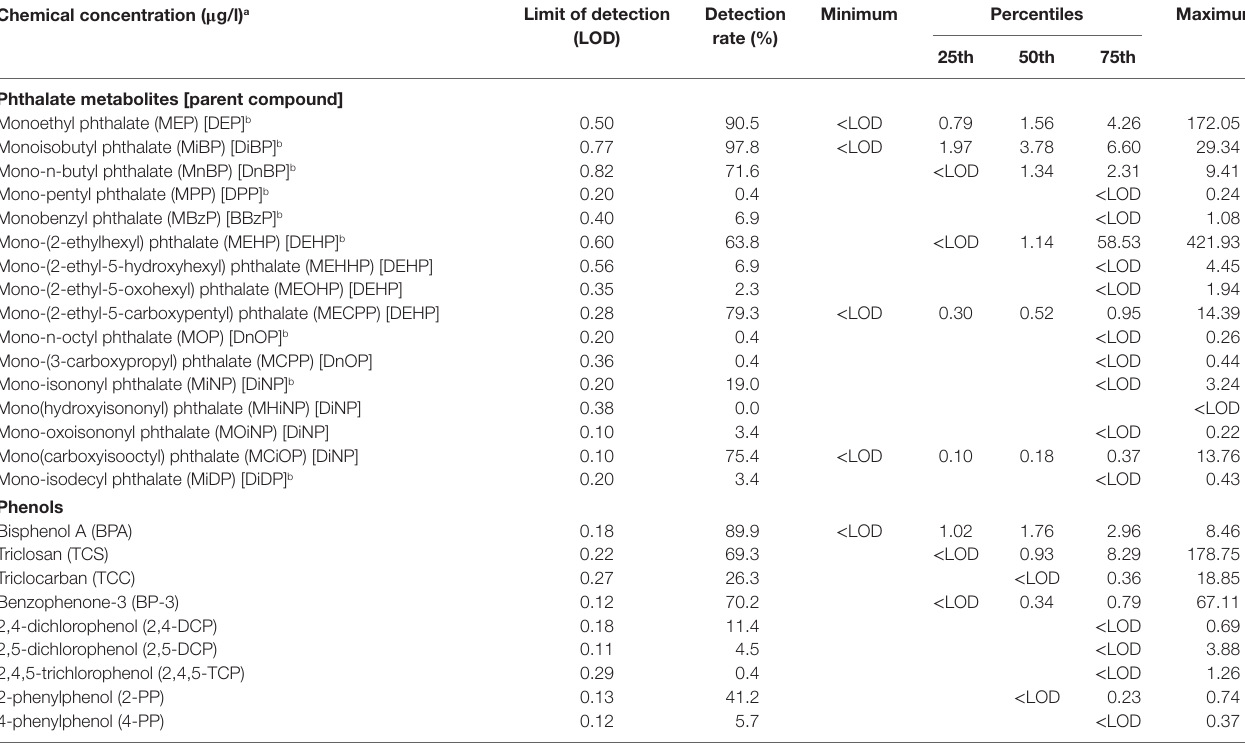
Table 1 | Medians, quartiles, and ranges of serum concentrations of the investigated phthalate metabolites and phenols in the study population ( n = 232 for phthalates, n = 228 for